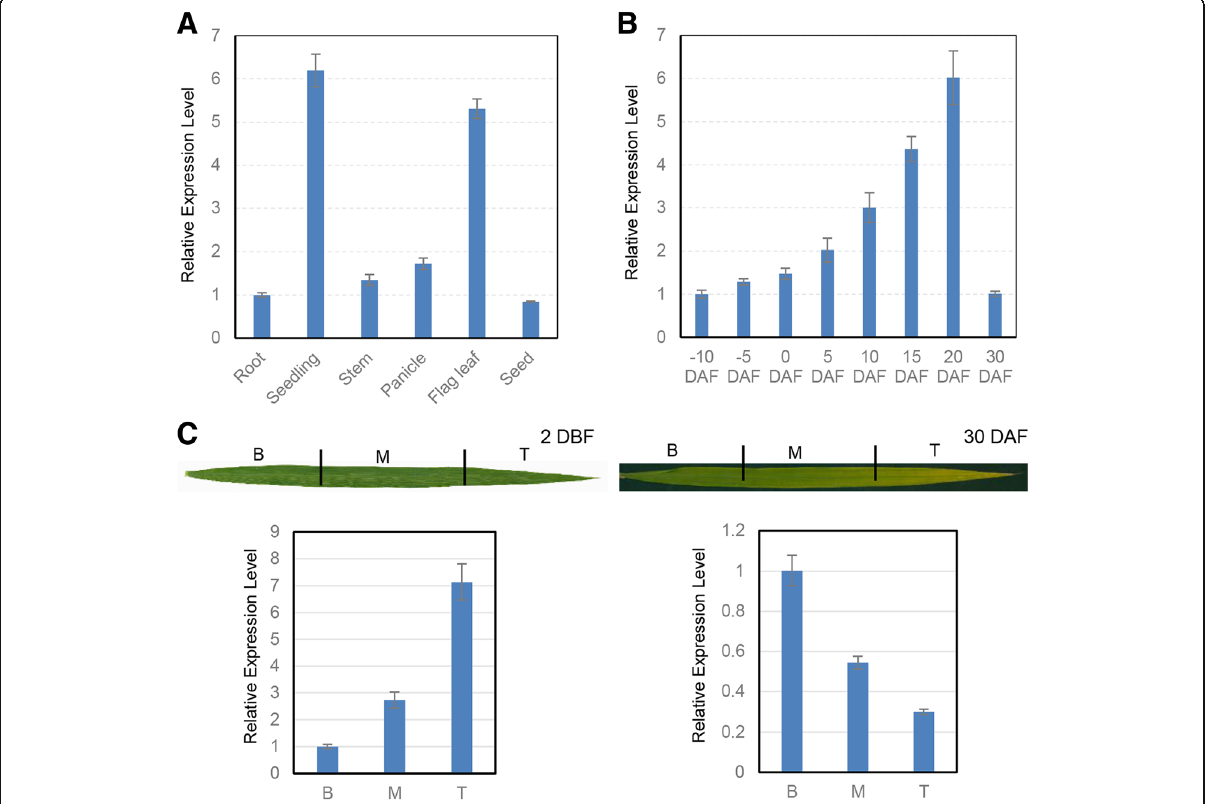
Fig. 5 Analysis of OsPSL expression. a Quantitative RT-PCR (qRT-PCR) analysis of OsPSL expression in various organs, including root and young seedling at the two-leaf stage, stem, panicle and flag leaf at booting stage, and seed 10 days after flowering (DAF). b Change over time in the OsPSL transcription levels of flag leaves. c OsPAL expression in different parts of the fully expanded flag leaf 2 days before flowering (DBF) and 30 DAF. B, base; M, middle; T,